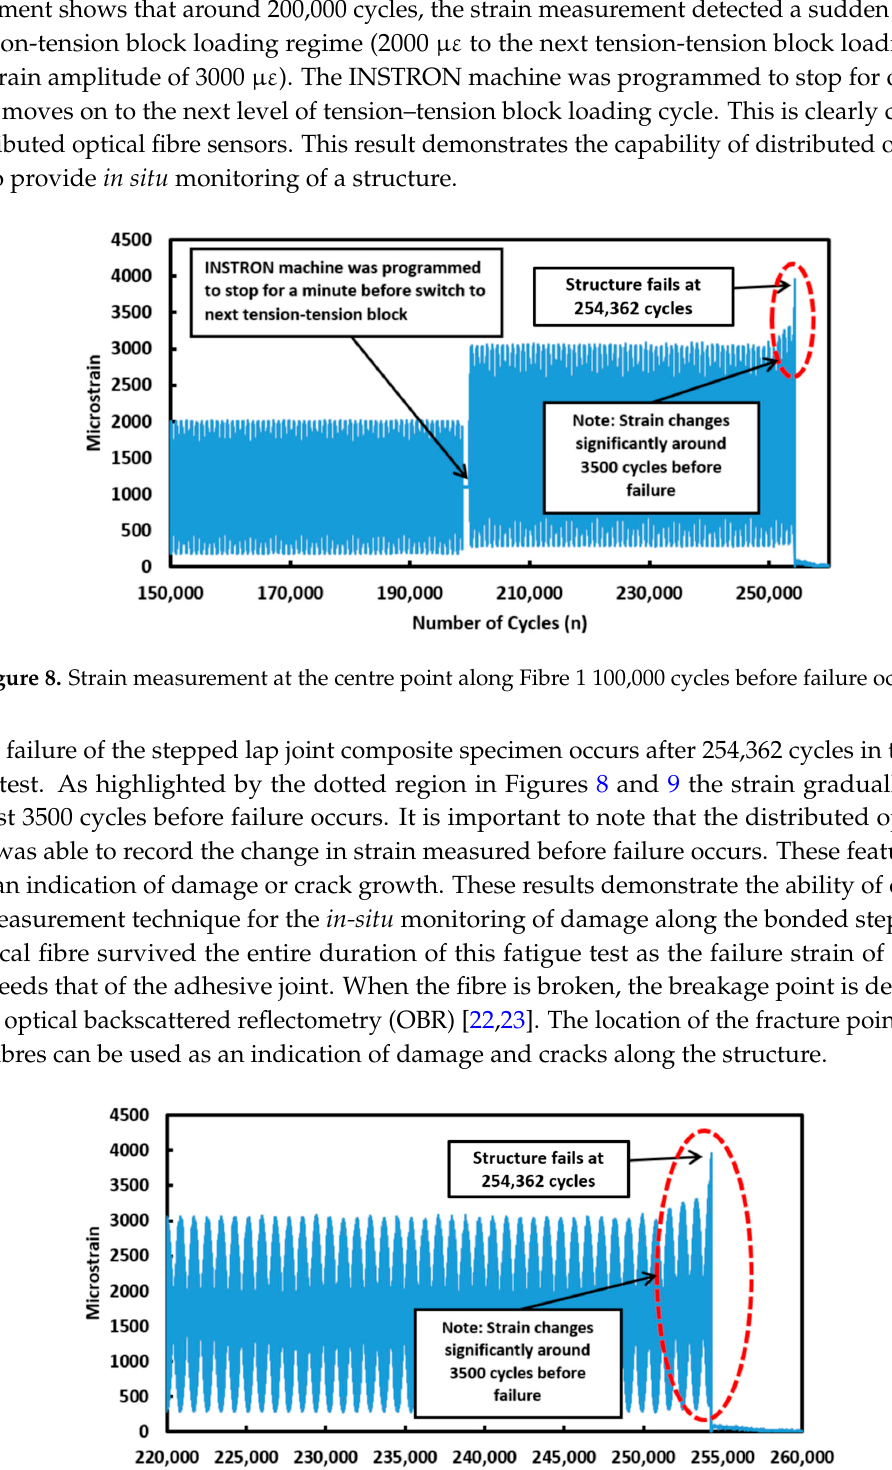
Figure 9. Strain measurement at the centre point along Fibre 1 35,000 cycles before failure occurs.